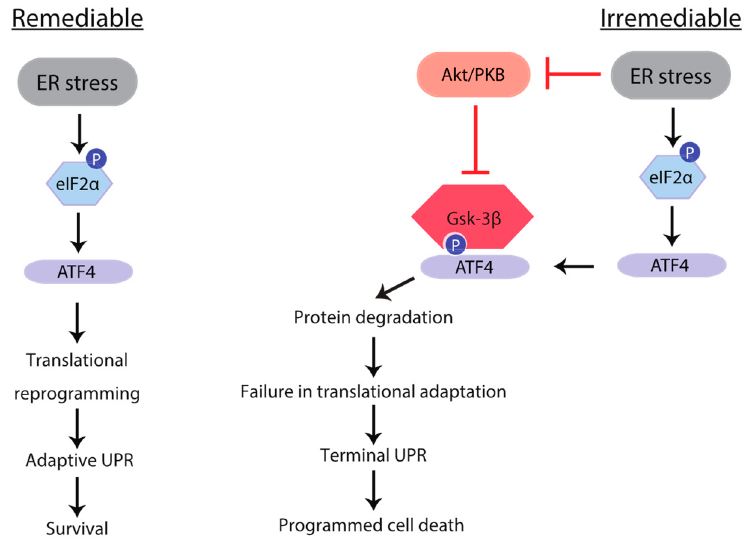
Figure 7. Schematic illustration of a role of GSK-3 on eIF2 α -ATF4 pathway under ER stress. When β cells face ER stress, eIF2 α phosphorylation suppresses global translation and paradoxically promotes ATF4 translation. ATF4 may switch translational suppression by eIF2 α to more adaptive suppression by inducing 4E-BP1. In this context, attenuation of the Akt-GSK-3 pathway facilitates ATF4 protein degradation, and thereby ER stress becomes irremediable, leading to apoptosis.